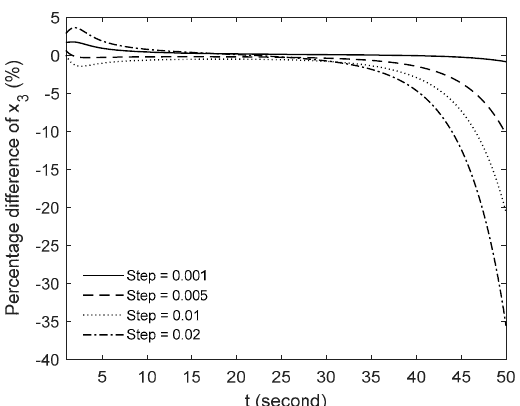
Figure 4. Percentage difference of x 2 between the exact solutions and the present method for different time steps h .